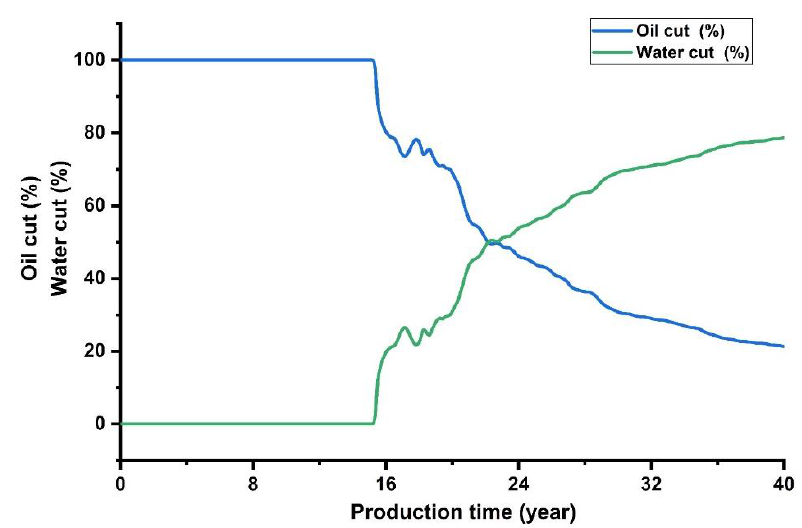
Figure 3. Oil cut and water cut of the produced fluid in the standard condition.